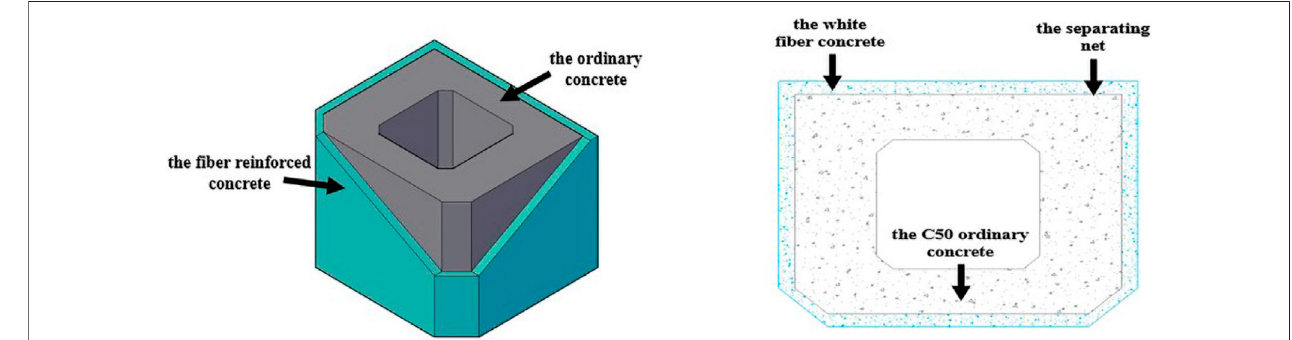
FIGURE 1 | The gradient structure.